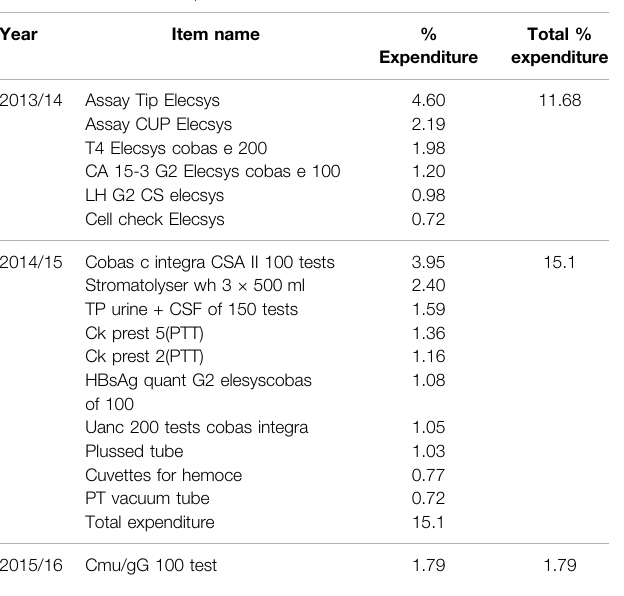
TABLE 6 | Class A Laboratory commodities that were not included in the VEN classi fi cation of SPHMMC, March